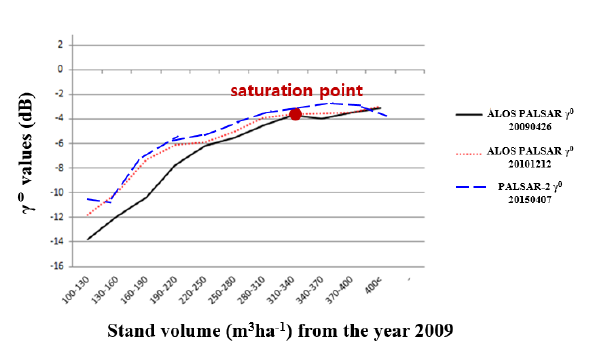
Fig. 2. Differences in the standing volume estimated from PALSAR-2 / ALOS PALSAR data